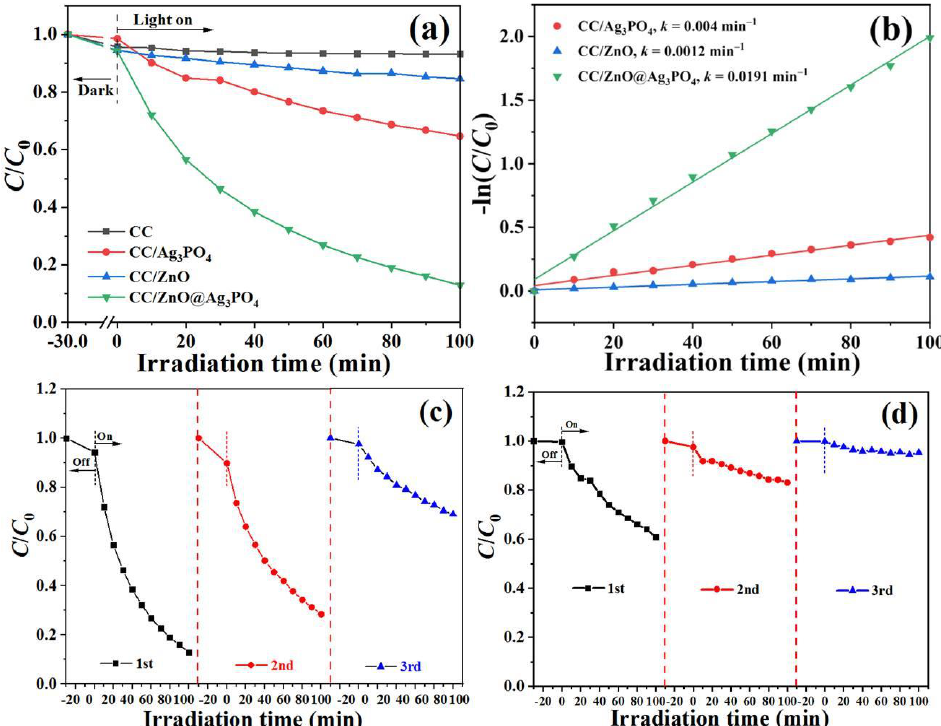
Figure 7. Comparison of the photocatalytic activities ( a ) and apparent reaction rate constants ( b ) of CC, CC/ZnO, CC/ZnO@Ag 3 PO 4 , and CC/Ag 3 PO 4 for the degradation of RhB under visible light irradiation, and photocatalytic recyclability of the CC/ZnO@Ag 3 PO 4 composite ( c ) and CC/Ag 3 PO 4 ( d ).